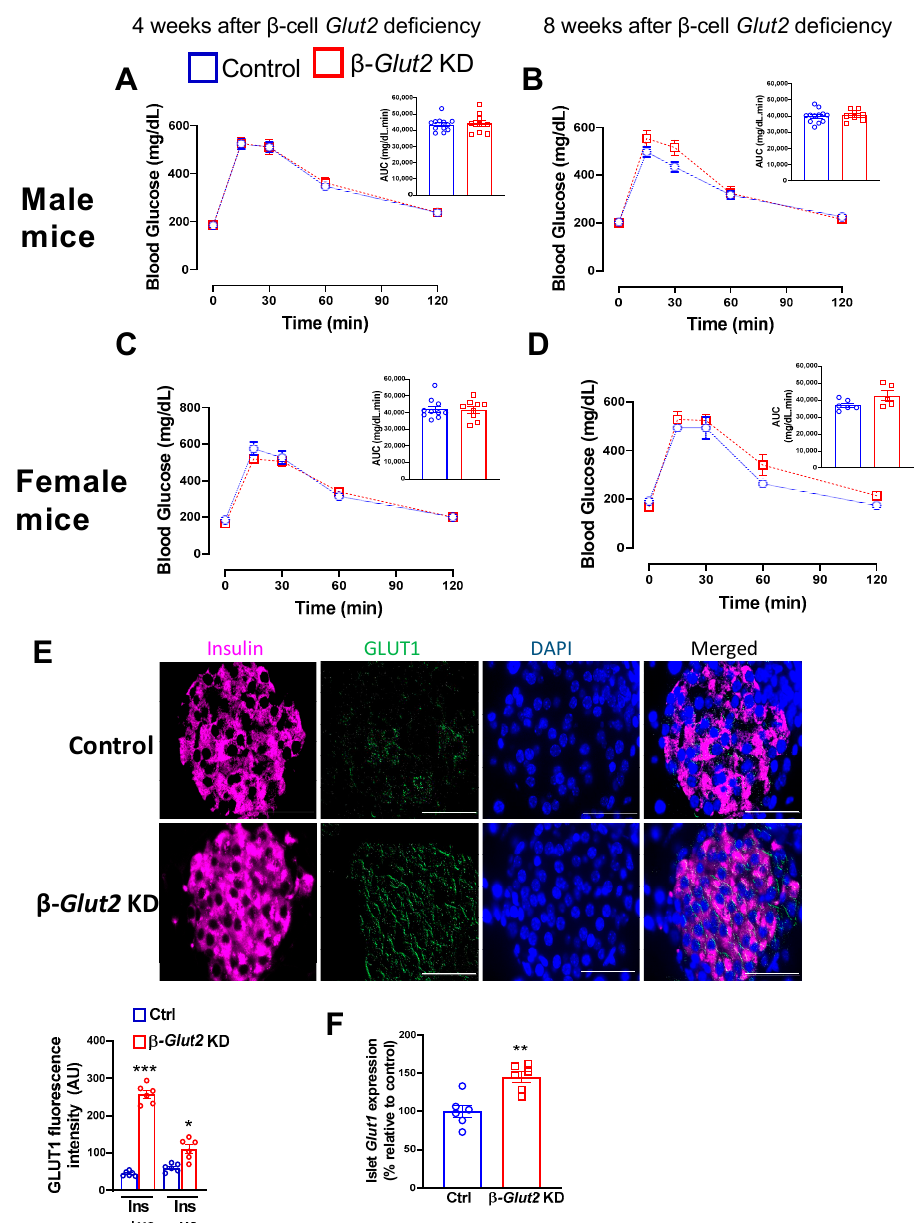
Figure 3. β -cell Glut2 knockdown ( β - Glut2 KD) mice exhibit normal glucose tolerance. Results obtained from oral glucose tolerance tests in male, n = 9 or 12 ( A , B ) and female, n = 6–10 ( C , D ) mice 4 ( A , C ) and 8 ( B , D ) weeks after inducing β -cell Glut2 deficiency. Area under the curve (AUC) is shown in inset bar graphs. The mice were 8–10 weeks old when β -cell Glut2 deficiency was induced. Immunofluorescence, n = 6 ( E ) and qRT-PCR, n = 6 ( F ) demonstrating upregulation of islet Glut1 in female β - Glut2 KD mice after completion of the study. 3 islets per section and 3 sections per mouse were quantified ( E ). Ins +ve and -ve, quantification of GLUT1 fluorescence in insulin positive and negative staining. Scale bar is 50 µm. Control, Glut2 loxP/loxP mice; AU, arbitrary unit. Student’s un- paired t -test was used for comparisons, * p < 0.05, ** p < 0.01, *** p < 0.001. Error bars are mean ± SEM.